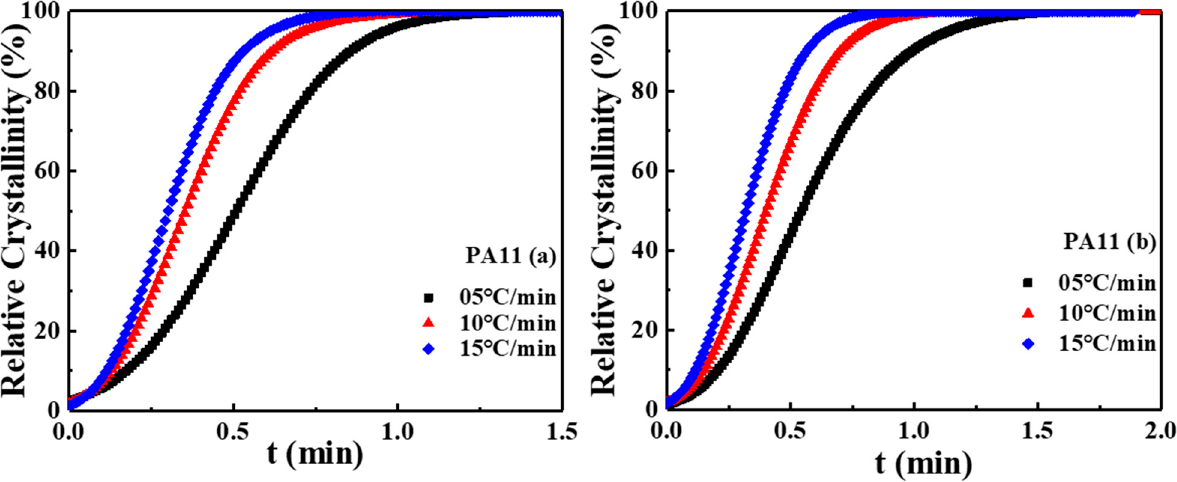
Figure 4. The relative crystallinity versus time for non-isothermal crystallization of two PA11 speci- mens at different cooling